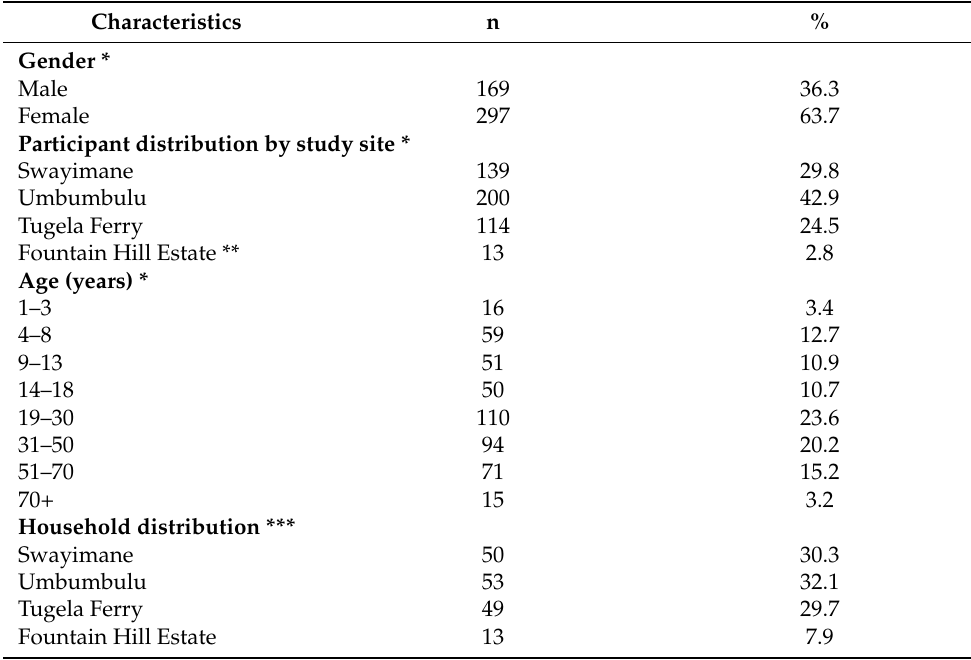
Table 1. Demographic characteristics of study